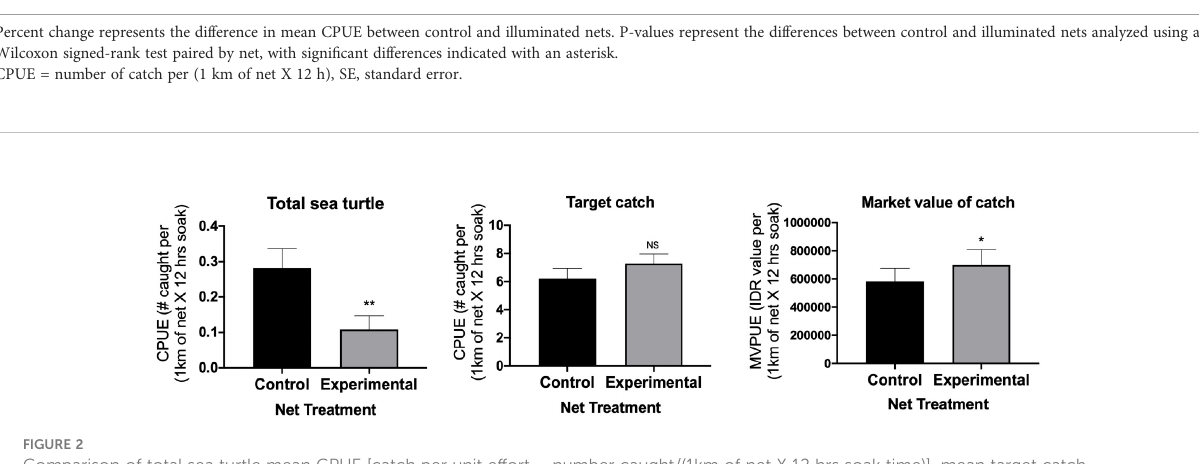
A total of 33 sea turtles were caught in the 70 paired net trials, with 24 turtles caught in the control nets and 9 in the experimental nets (Figure 1B, Table 2). Most sea turtles caught were green turtles, with 14 in control nets and 6 in illuminated